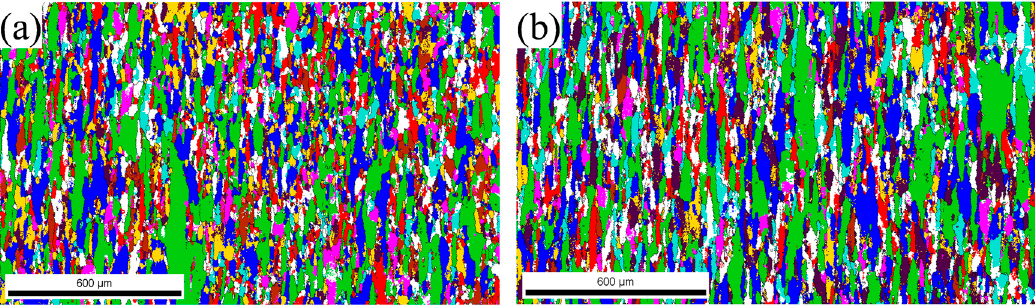
Figure 2. EBSD image of indirectly extruded 7A99 aluminum alloy plates subjected to T6 and T6-DCT reatments. ( a ) T6; ( b ) T6-DCT.